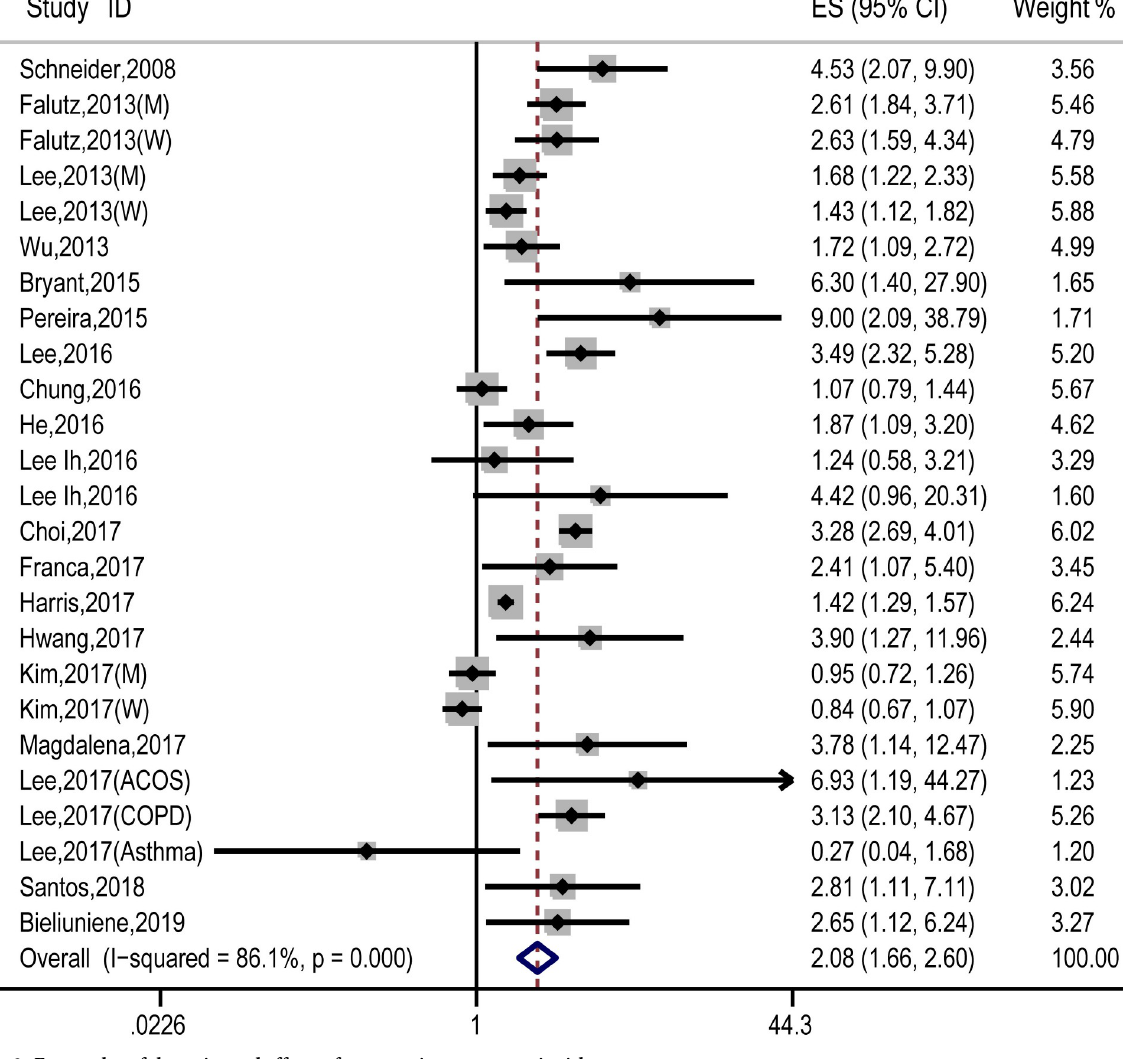
Fig 2. Forest plot of the estimated effects of sarcopenia on osteopenia